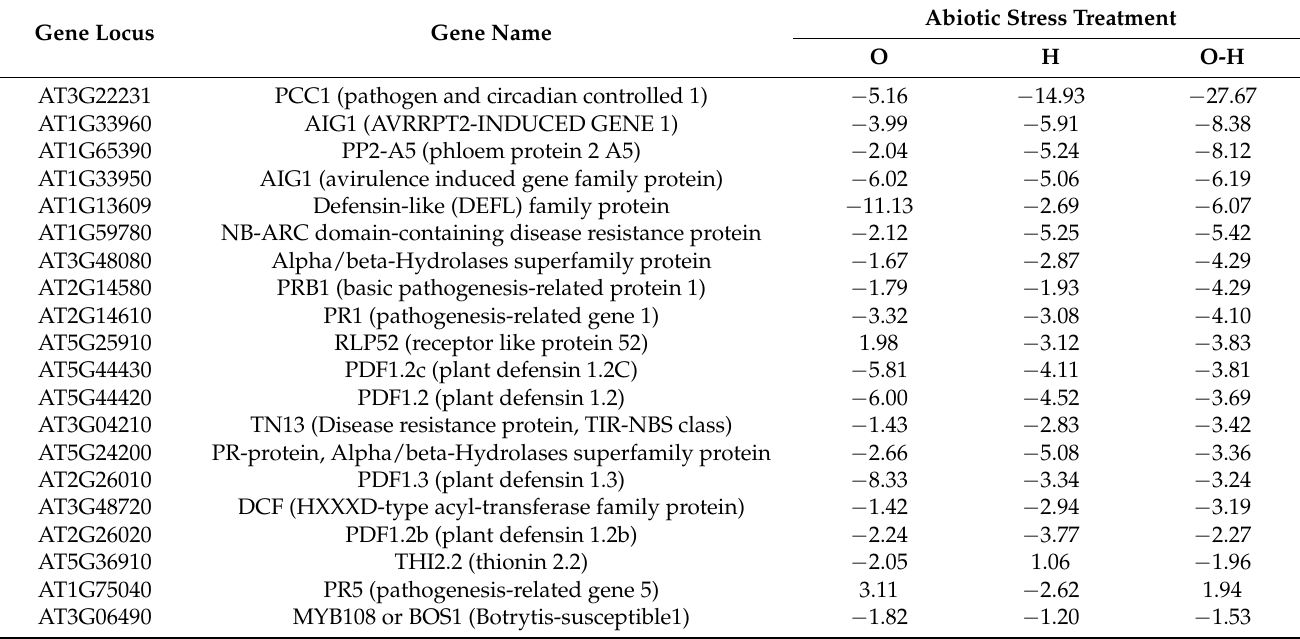
Table 1. List of 20 highly repressed defense-related genes taking into account the individual or the combined osmotic and heat treatment.